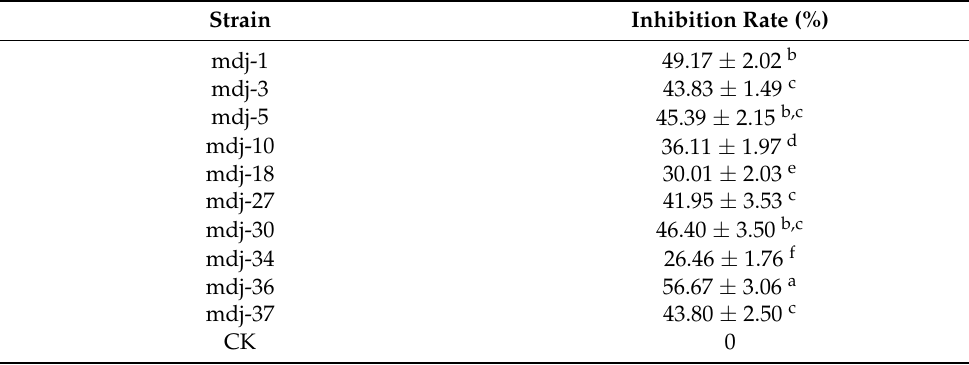
Table 1. Inhibition rate of F. oxysporum FO2016038 by bacteria isolated from rice samples.